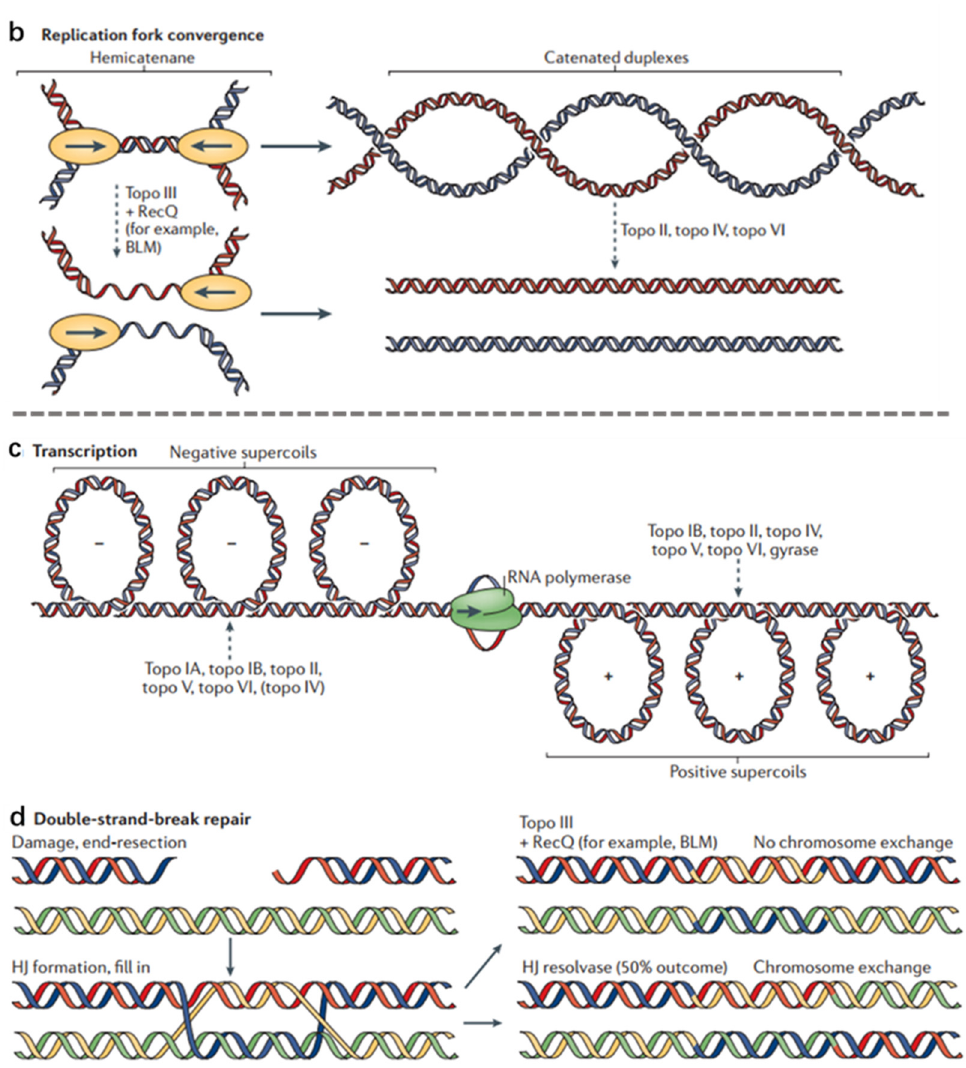
Figure 1. Topoisomerase functions during DNA replication and DNA repair. Topological problems that arise during DNA replication. The names of the topoisomerases that resolve these superstructures are listed. Topoisomerase action is indicated by a dashed arrow. ( a ) Replication elongation. As a replisome progresses, positive supercoils form ahead of the fork, and newly replicated precatenanes form behind it. If unresolved, precatenanes can give rise to tangled or catenated DNAs that lead to abnormal DNA segregation on entry into cell division. Unresolved positive supercoils can impede fork progression and terminate DNA replication prematurely. ( b ) Replication fork convergence. Hemicatenanes are formed as two forks converge, and must be resolved before chromosome segregation can occur. The unreplicated parental duplex can be unlinked by topo III, together with a RecQ-family helicase, after which the single-stranded gaps are filled in. Alternatively, the unreplicated parental duplex can be replicated to form a catenane with duplex linkages, which are then removed by a type II topoisomerase. ( c ) The formation of positive and negative supercoils and the names of topoisomerases acting on these superstructures. ( d ) Double-strand-break repair through homologous recombination. The broken DNA can be repaired by forming a double Holliday junction (HJ). Topo III, together with a RecQ-type helicase, can resolve these junctions, generating disentangled chromosomes that have no crossovers between DNA ends. At the same time, there is a 50% probability of producing chromosomes with chromosome arms exchanged. Adapted from